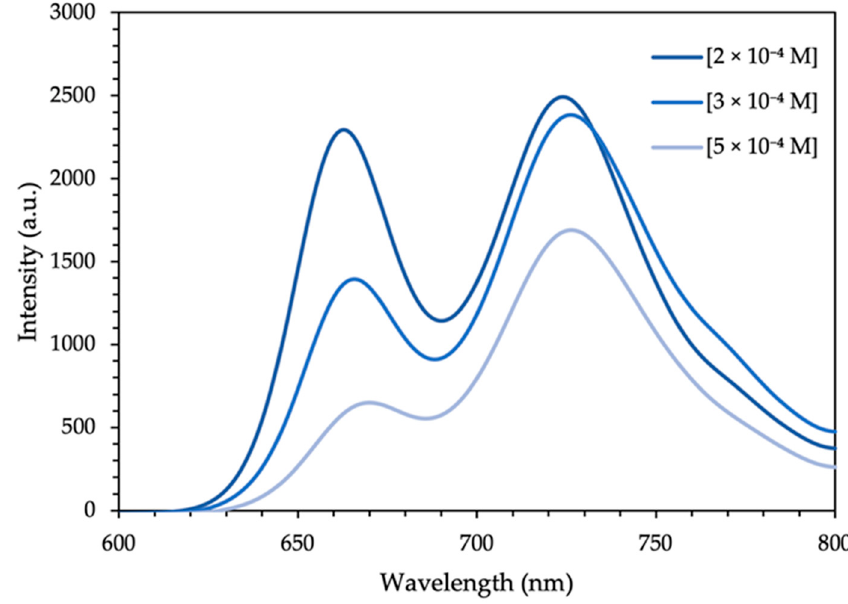
Figure 3. Emission spectra of H 2 P in different concentrations.